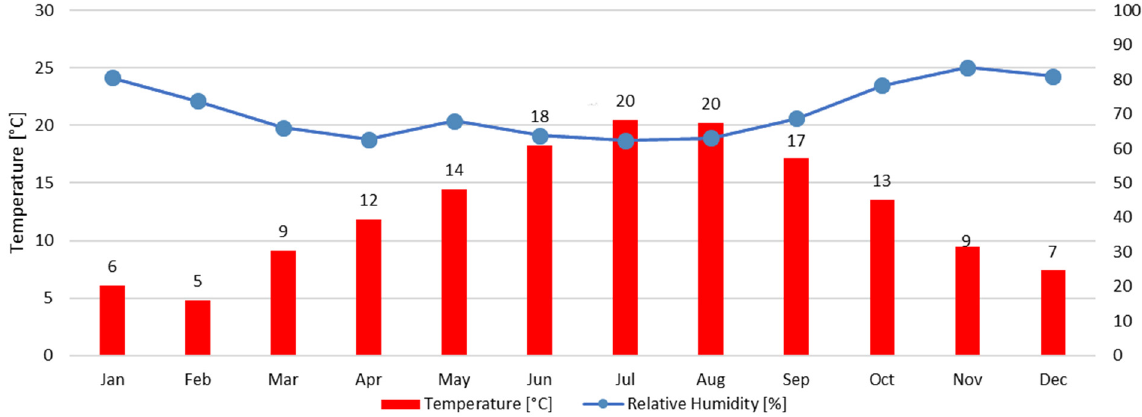
Figure 16. Paris t and r.h. during the average year.